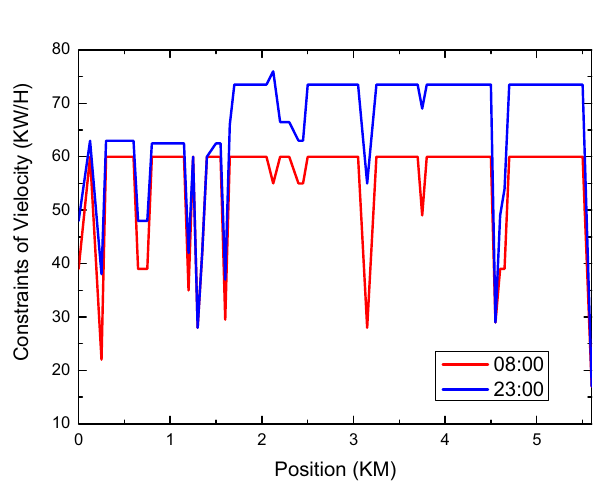
Figure 9. This figure reflects the constrains of velocity between 8 a.m. and 11 p.m. From the figure, we can see that the value of 11 p.m. is greater than that of 8